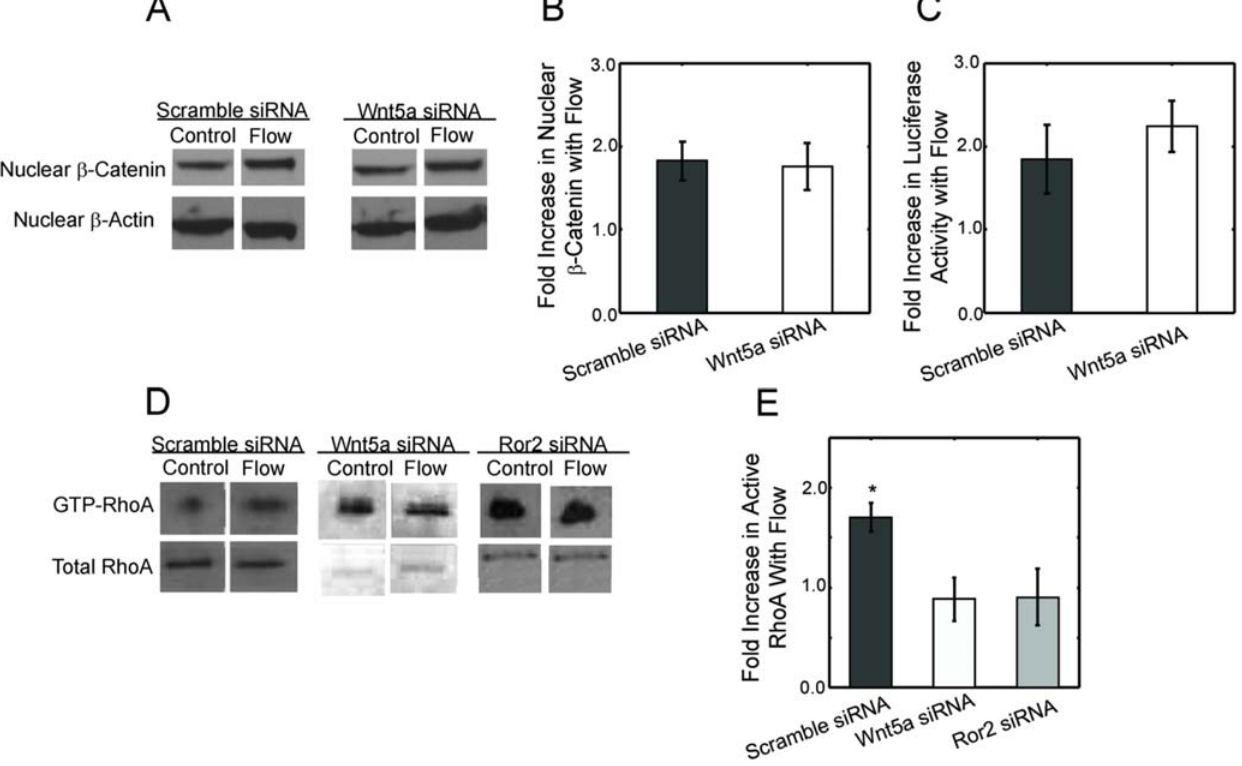
Figure 4. Wnt5a and Ror2 are necessary for flow-induced RhoA activation, but do not effect b -catenin translocation. (A) Western blots of nuclear b -catenin indicate that both scrambled and Wnt5a siRNA treated cells maintained their potential to initiate b -catenin signaling with flow. (B) Analysis of the western blots demonstrates that scrambled and Wnt5a siRNA treated cells had a 1.9 6 0.2-fold and 1.8 6 0.3-fold increase in nuclear b -catenin with flow, respectively. (C) b -catenin/TCF/LEF transcription of downstream genes was also maintained in both scramble and Wnt5a treated cells with a 1.8 6 0.4-fold and 2.2 6 0.3-fold increase in luciferase activity, respectively, indicating that Wnt5a is not necessary for mechanically induced b -catenin signaling. (D) Western blots were used to assay Rho activation in response to flow in scrambled, Wnt5a and Ror2 siRNA treated cells. (E) Analysis of the blots indicates that the 1.7 6 0.1-fold increase observed in scrambled treated cells is significantly greater than Wnt5a (p , 0.01) and Ror2 (p , 0.05) siRNA treated cells, both of which lost flow-induced RhoA activation. (Error bars: SEM (n $ 4)).